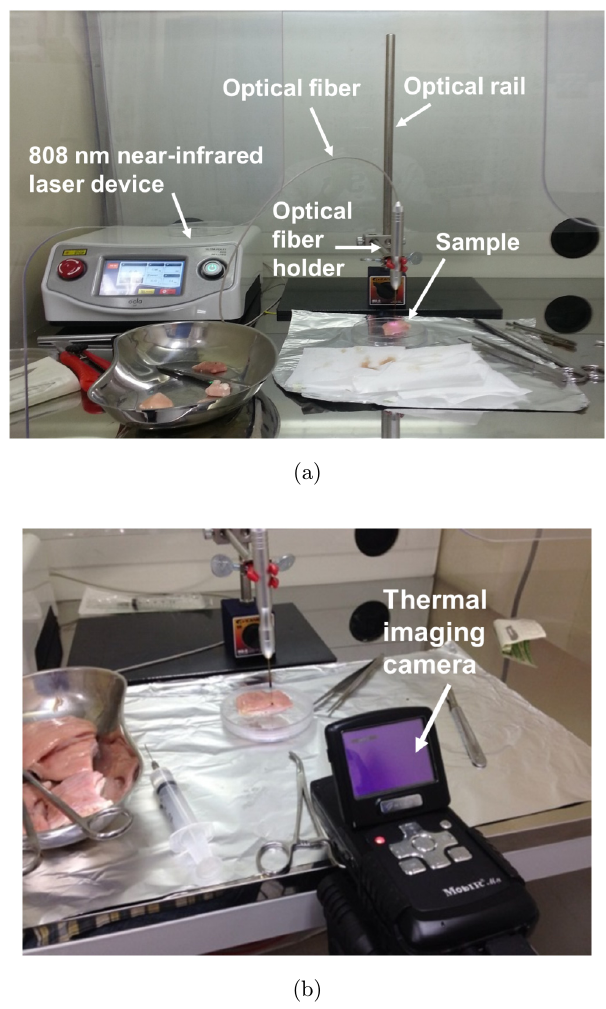
Fig. 1. (a) Experimental setup showing the 808-nm infrared laser device and the irradiation of porcine tissue sample with an optical ¯ber, an optical ¯ber holder and a vertically movable optical rail. (b) Thermal imaging setup for measurement of the cross-sectional temperature distribution in the porcine stomach tissue.